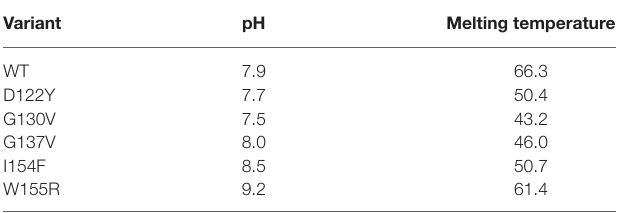
TABLE 1 | Comparison of the melting temperatures of the different frataxin variants . Variant pH